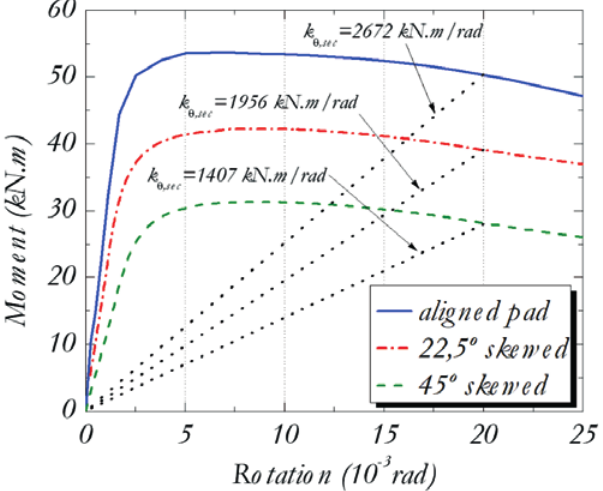
Figure 5 Numerical moment-rotation response obtained from the grillage model for aligned and skewed pads